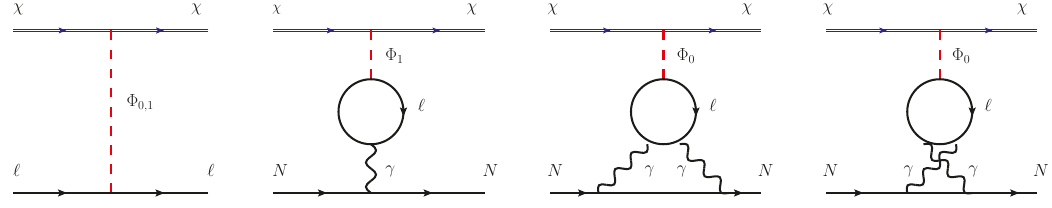
Figure 2 . Feynman diagrams for LDM scattering with electron and